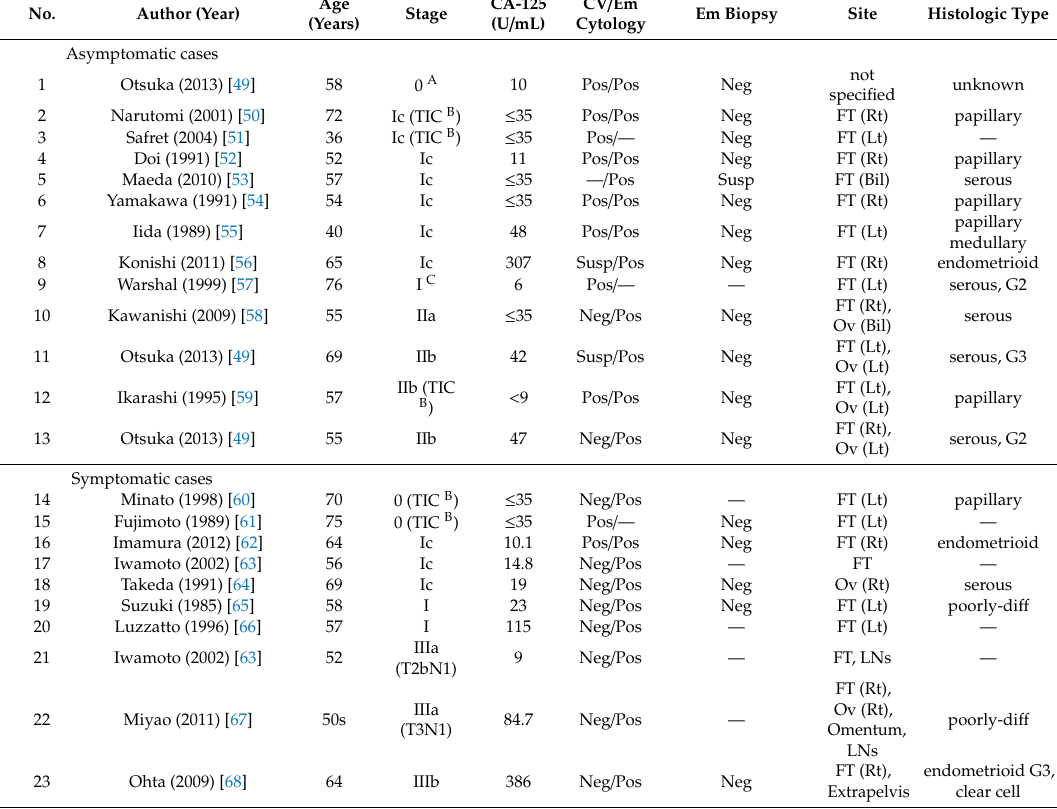
Table 2. Cases of fallopian tube and ovarian cancer detected by endometrial / cervicovaginal cytology without abnormalities on imaging